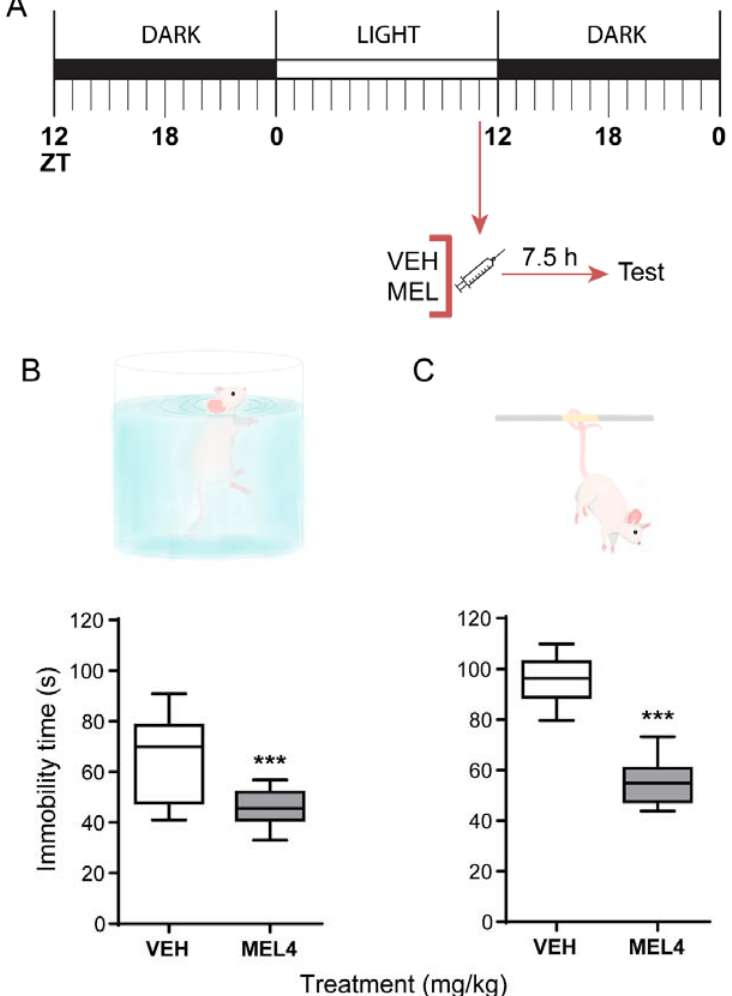
Figure 2. Effect of a single dose of melatonin at ZT11 on two behavioral tests in mice: forced swimming test (FST) and tail suspension test (TST). ( A ) Melatonin treatment protocol. ( B ) Effect of melatonin (4 mg/kg; MEL4) on the immobility time of mice subjected to the FST. ( C ) Effect of melatonin (4 mg/kg; MEL4) on immobility time in the TST. For each test, a vehicle-treated group (VEH) was included. Data show median and distribution for 8 mice per group. Statistical differences were assessed with Student t -test; *** p ≤ 0.001.